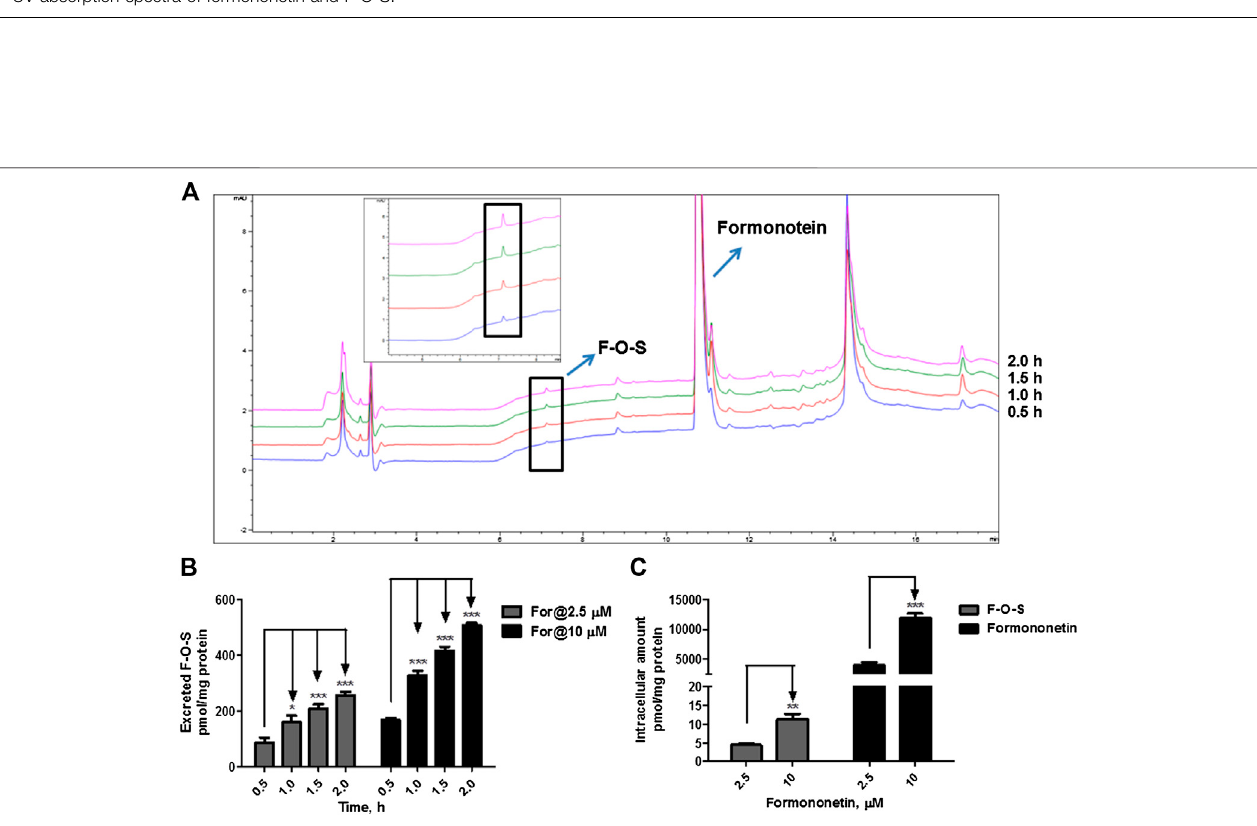
FIGURE 3 | Disposition of formononetin in HEK-SULT1A3 cells at different loading doses. (A) Representative HPLC chromatograms showing that formononetin sulfate (F-O-S) was generated after incubation with HEK-SULT1A3 cells at different time points and excreted into extracellular medium. (B) Excretion rates of formononetin sulfate (F-O-S) at dose of 2.5 μ M and 10 μ M, respectively. (C) Intracellular amounts of formononetin and F-O-S at 2 h after incubation under different loading doses. * p < 0.05, ** p < 0.01, *** p < 0.001 compared with control. Each data point was shown as mean ± SD (n (cid:1) 3).